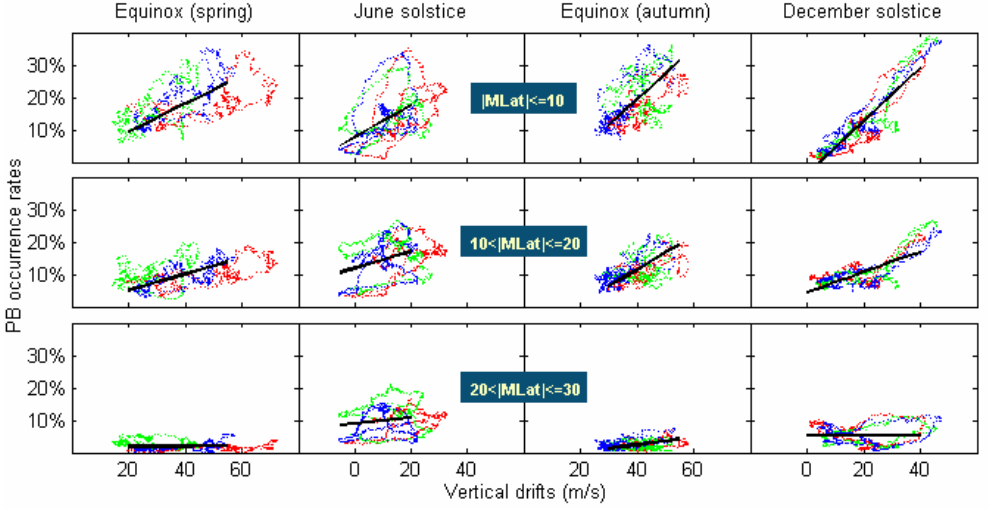
Figure 3. Plot of the plasma bubble occurrence probability and the evening equatorial pre-reversal vertical drifts for the same longitude grid during the period year 2000–2002. equinoctial months. For latitudinal belt 10 ◦ < | MLat | < =20 ◦